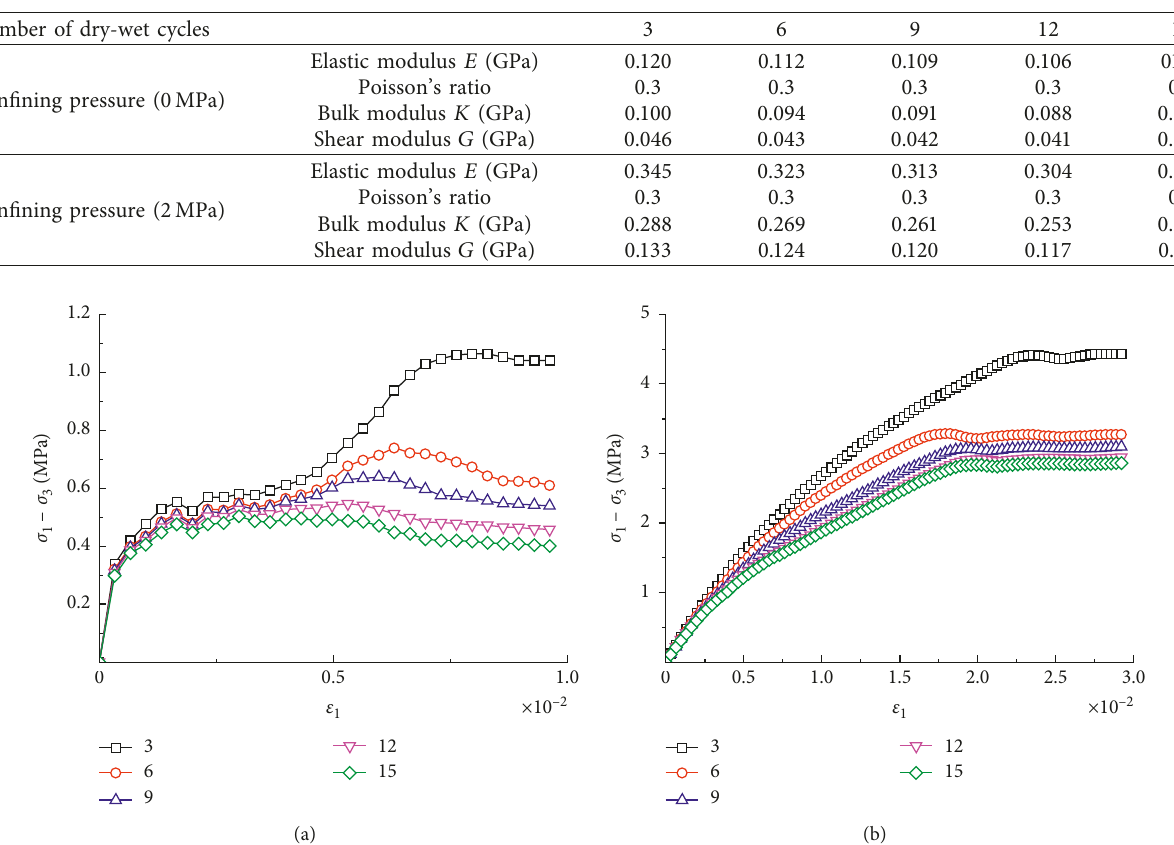
Table 7: Elastic parameters under different dry-wet cycles at 105 ° C.